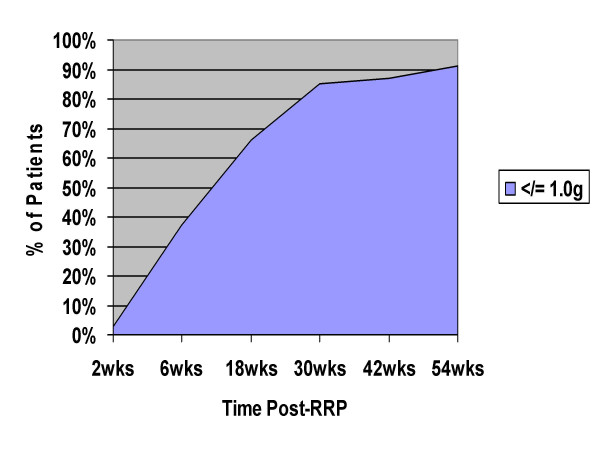
Continence Recovery Over Time.